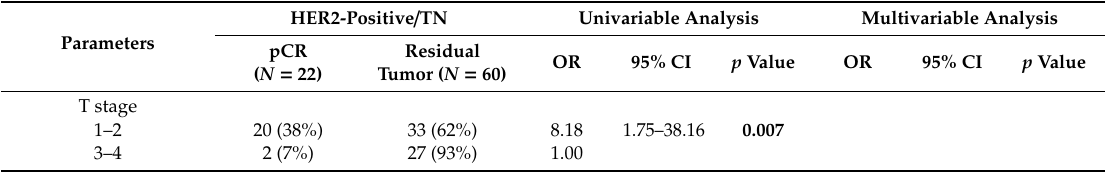
Table 2. Univariable and multivariable logistic regression analysis of predictive factors for pCR in HER2-positive and triple negative (TN)